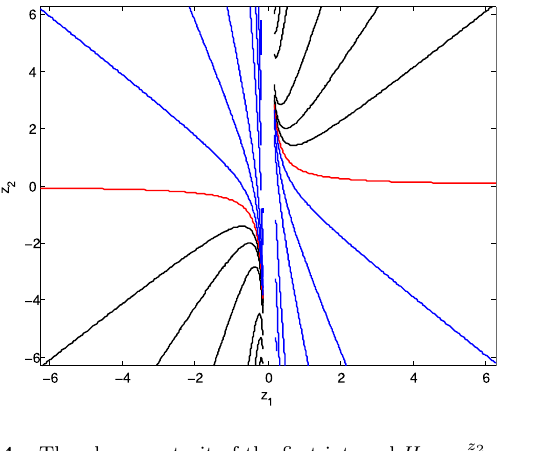
Figure 14. The phase portrait of the first integral H 3 = z 2